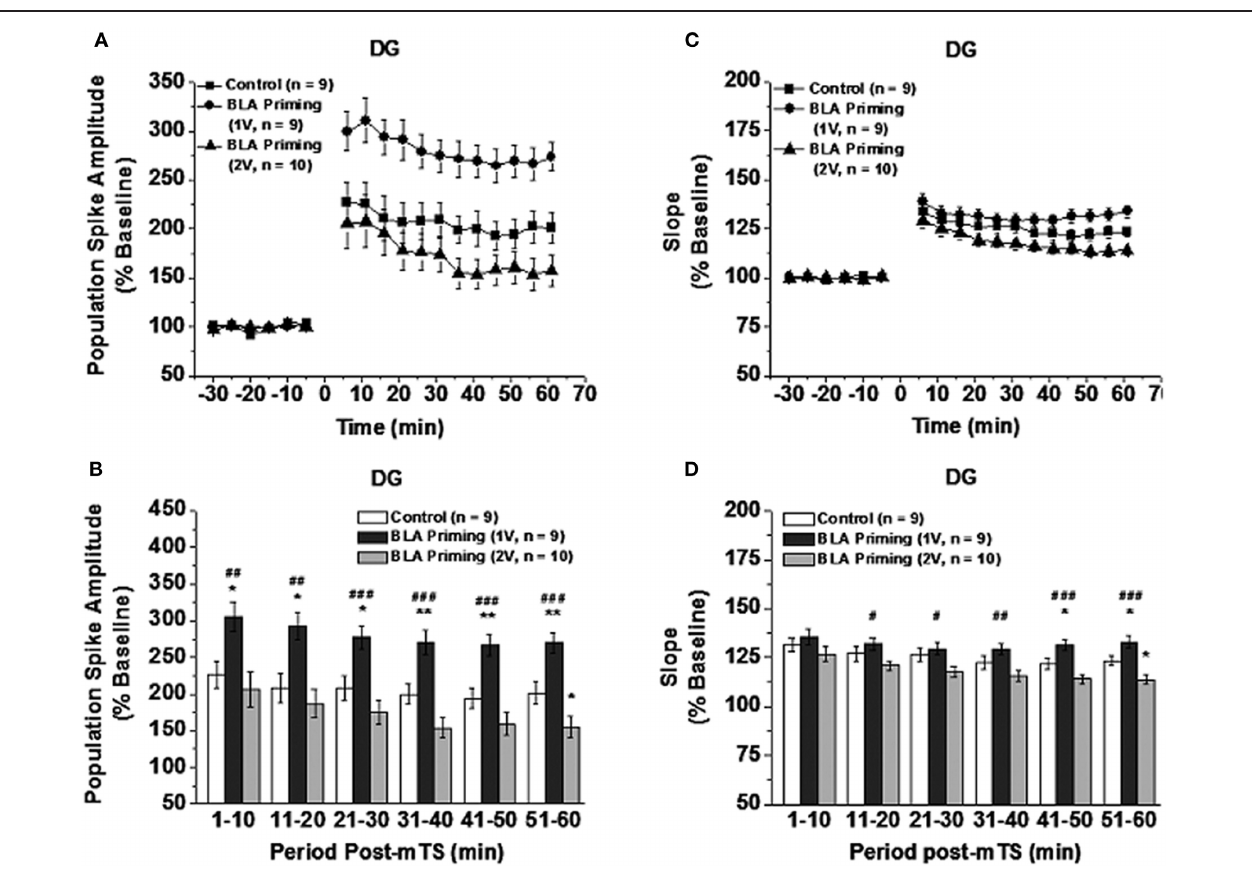
activation enhanced while the 2V-BLA priming activation impaired the PS amplitude ( summarized in B) and the slope ( summarized in D) of the EPSP component (Two-Way ANOVA with LSD as post-hoc ). ∗ p < 0 . 05 and ∗∗ p < 0 . 01 compared with the control; # P < 0 . 05, ## P < 0 . 01, and ### P < 0 . 001 compared with the 2V-BLA priming